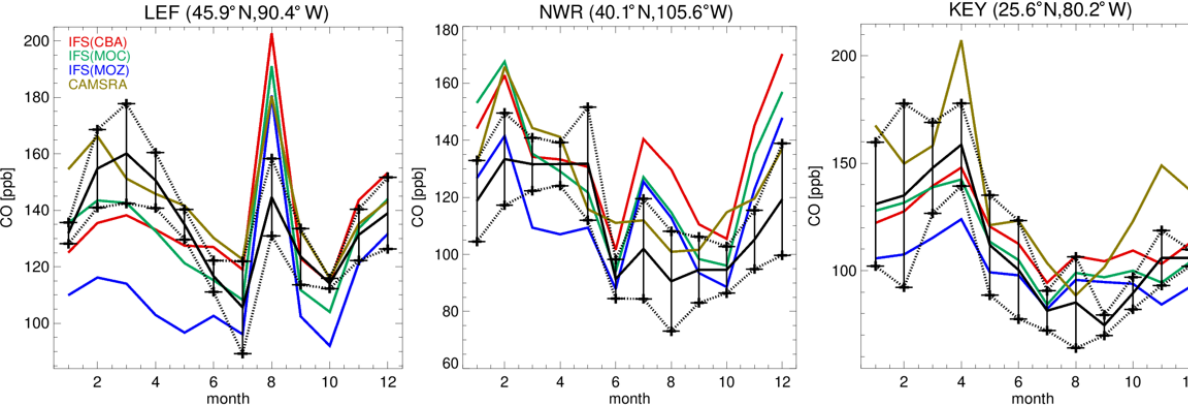
Figure 8. Comparisons of monthly mean surface CO mixing ratios at three separate surface measurement sites across the US. The observa- tional monthly means with the variability are shown in